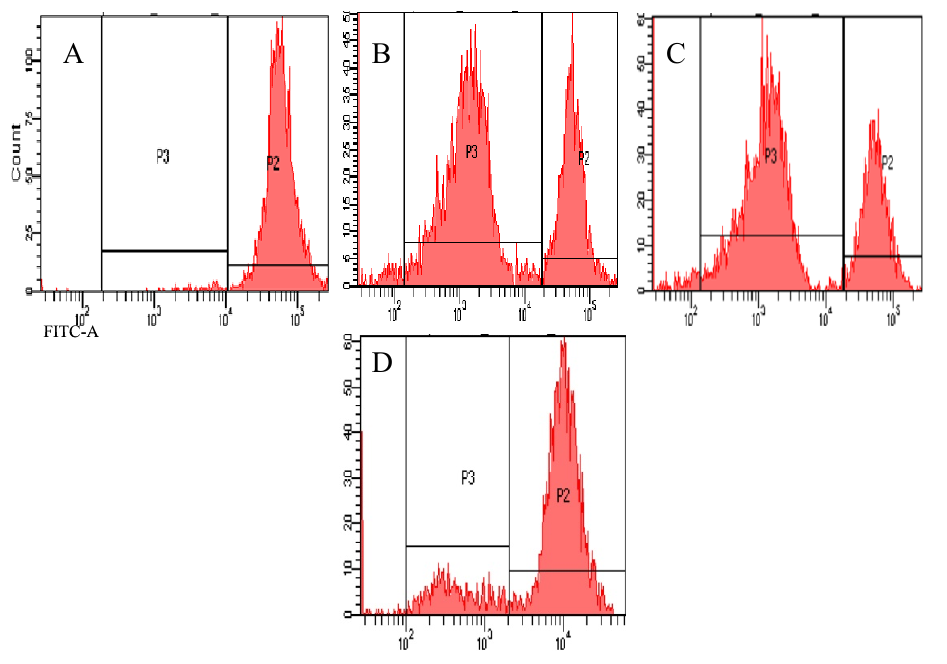
Proliferation of β 6-1- and β 6-2-stimulated lymphocytes. (A) Unlabeled and unstimulated cells were used as the negative control. (B) Proliferation of T lymphocytes by PHA stimulation (positive control). (C) Proliferation of T lymphocytes in response to β 6-1 stimulation. (D) Proliferation of T lymphocytes in response to β 6-2